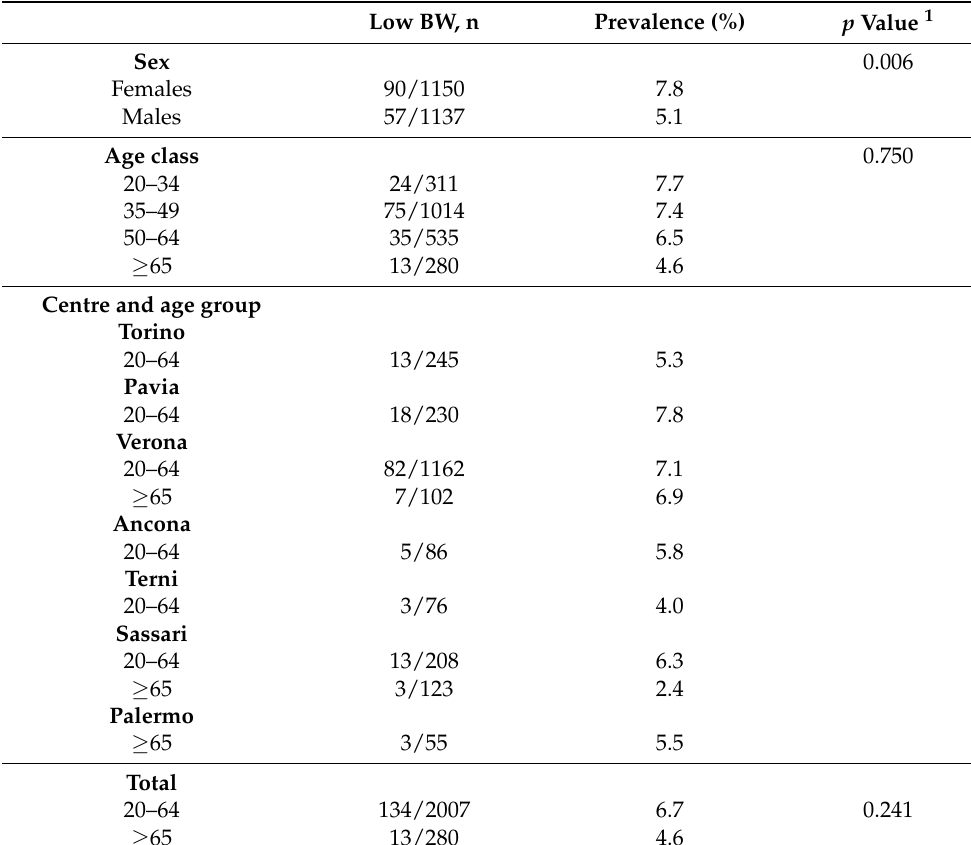
Table 1. Prevalence of low BW (<2500 g) by sex, age class and centre of interview (n =